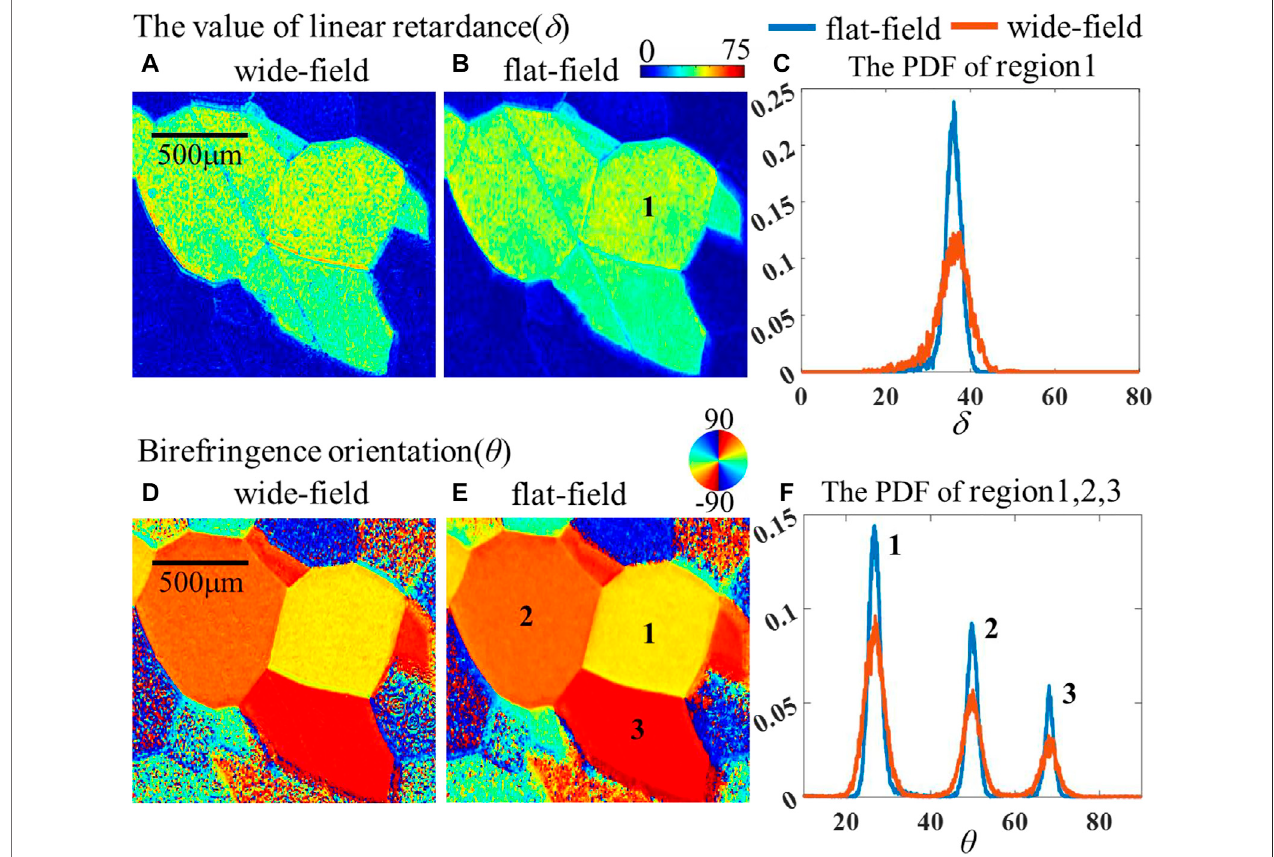
FIGURE8| Comparison ofPAAintwosystems: (A) δ forthewide- fi eld; (B) δ forthe fl at- fi eld; (C) distribution ofthe δ intwosystems; (D) θ forthewide- fi eld; (E) θ of fl at- fi eld; (F) distribution of θ in two systems.